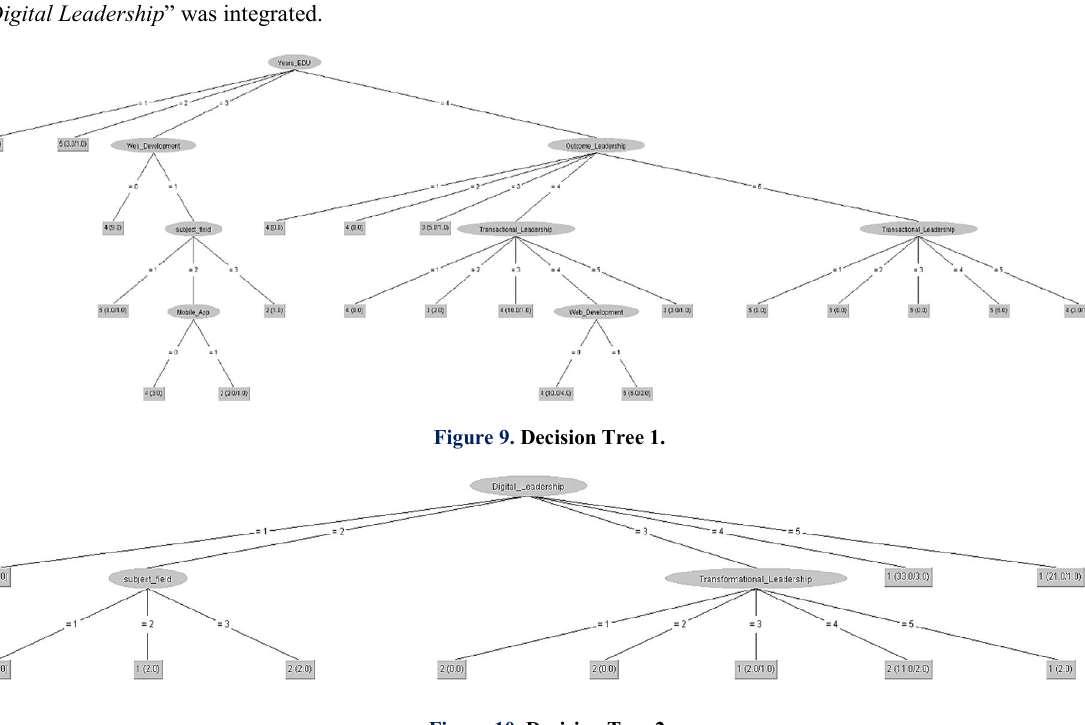
Figure 10. Decision Tree